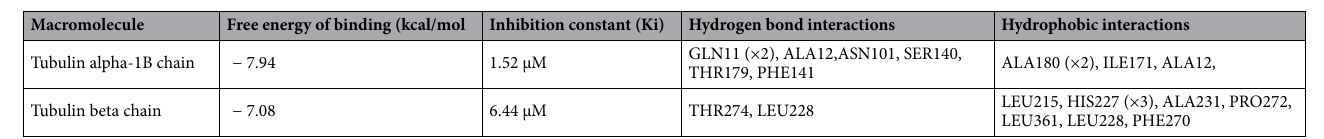
Table 5. Potential molecular interactions and binding affinities of AFM 1 with tubulin proteins.